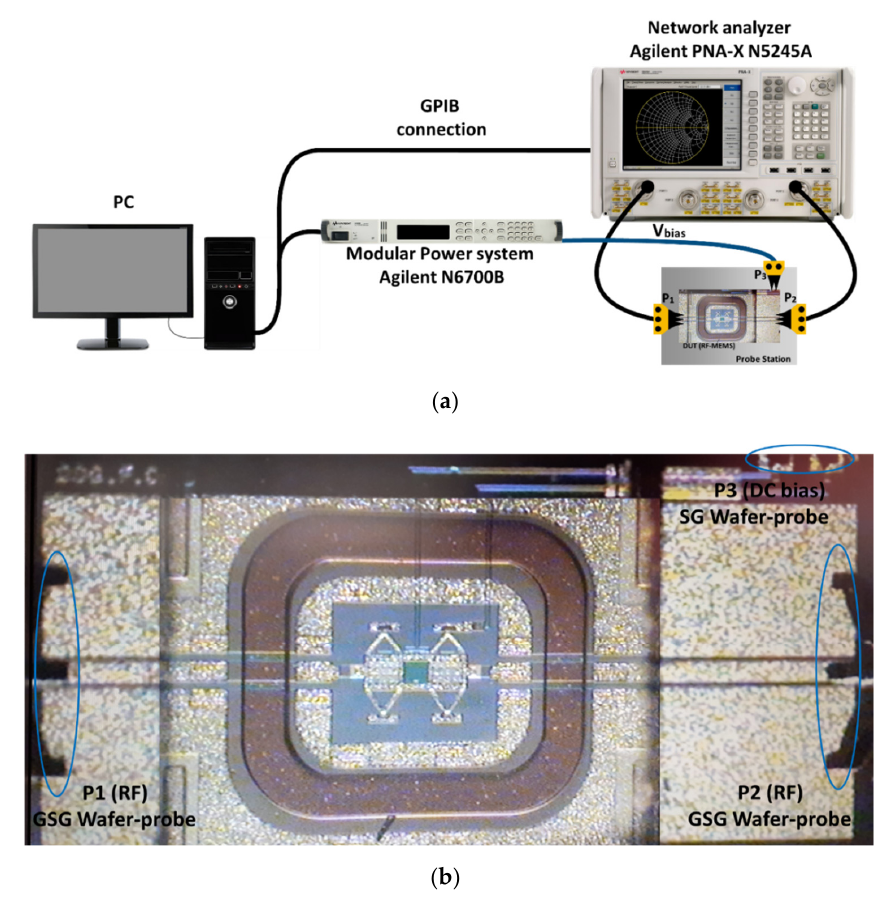
Figure 9. RF ‐ MEMS switch characterization. ( a ) Experimental test bench for DC and RF characterization. ( b ) Picture of a measured RF ‐ MEMS switch showing details of the GSG wafer probes for RF contacts and SG wafer probe for DC bias.